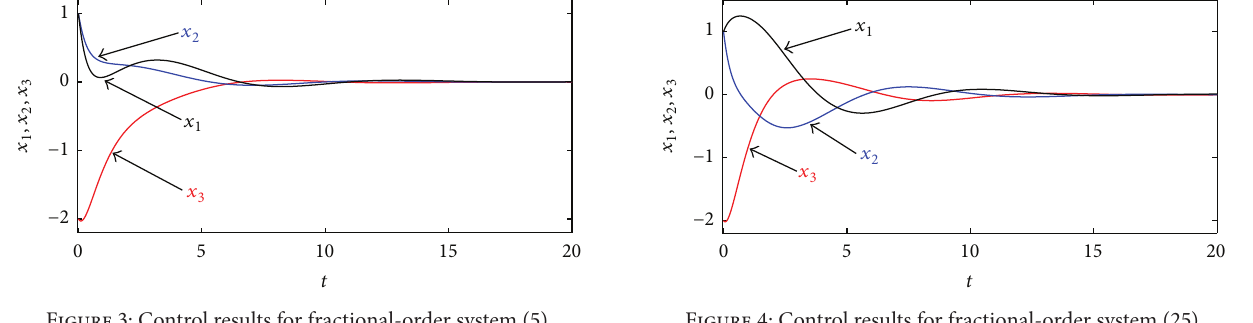
Figure 3: Control results for fractional-order system (5). Figure 4: Control results for fractional-order system